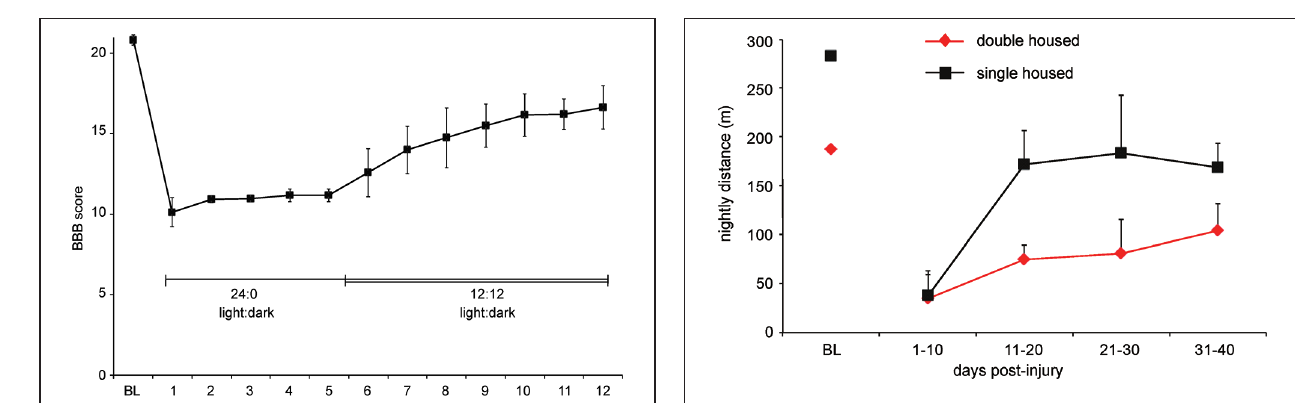
FIGURE 4 | Rats traverse a significantly greater distance when housed in pairs as compared to single housed. Graph shows total distance traveled for female SD rats with 12.5 g-cm NYU contusive injuries at T10 in standard 10” × 18” cages. Digital video was made of 1 min for every 10 min throughout the dark (12 h) period. Video was made a 4 Hz using a Basler 602f camera and custom-built IR lighting. Distance was determined using MaxTraq by Innovision Systems for three nights from each 10 day bin. Data is shown as mean ±